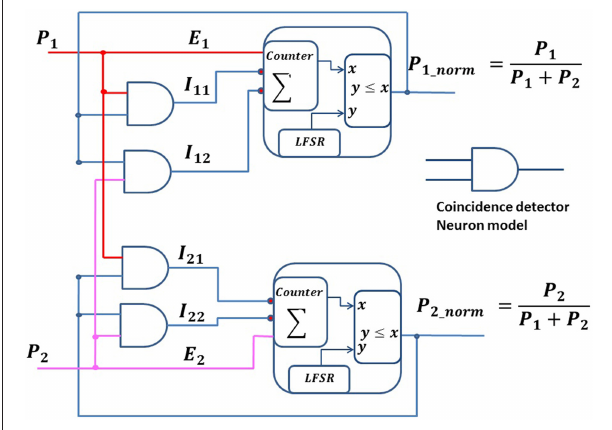
FIGURE 6 | Normalization neuronal circuits. The schematic shows two normalization circuits that normalize the spike train inputs, P 1 and P 2